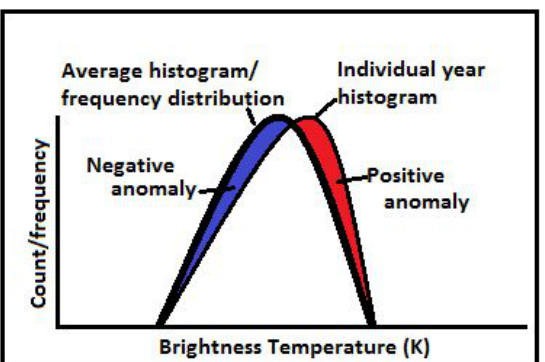
Figure 2. Conceptual diagram showing average histogram (thick black line) for all years compared to an individual year histogram (thin black line) and the positive (red) and negative (blue) anomaly brightness temperature